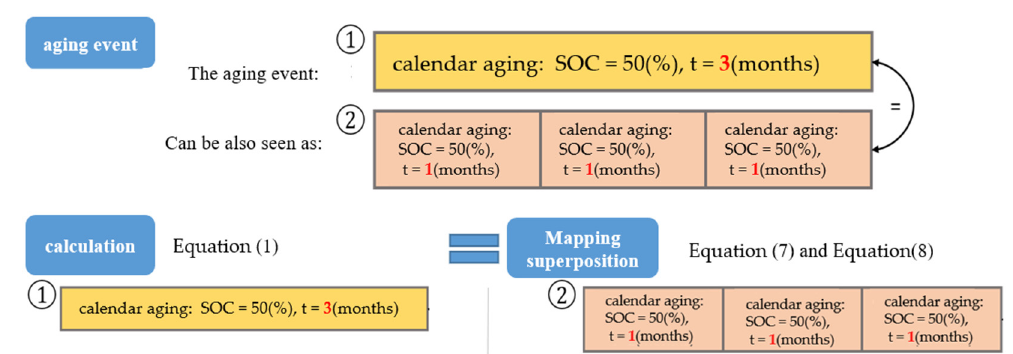
Figure 12. A schematic diagram for mapping superposition.